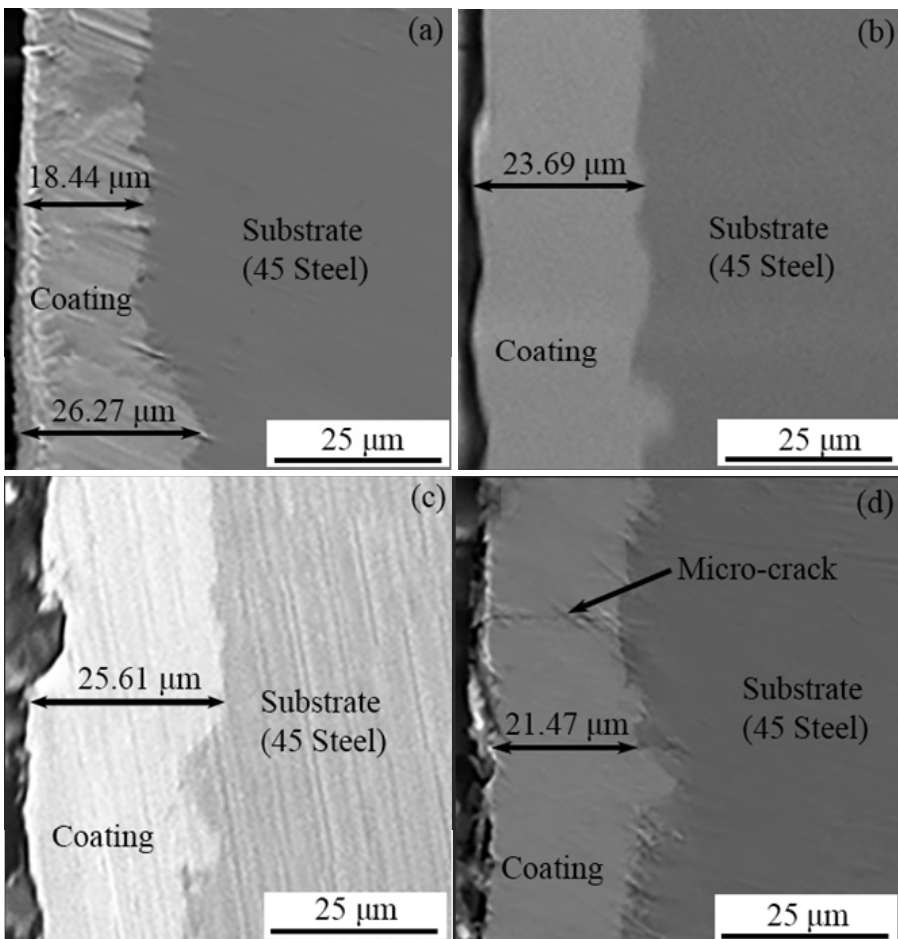
Figure 7. SEM micrographs illustrating coating cross sections of the Ni-W/SiC nanocomposite coatings obtained at different SiC concentrations—( a ) 0 g L − 1 , ( b ) 3 g L − 1 , ( c ) 6 g L − 1 and ( d ) 12 g L − 1 —on grit-blasted 45 steel substrate surfaces.